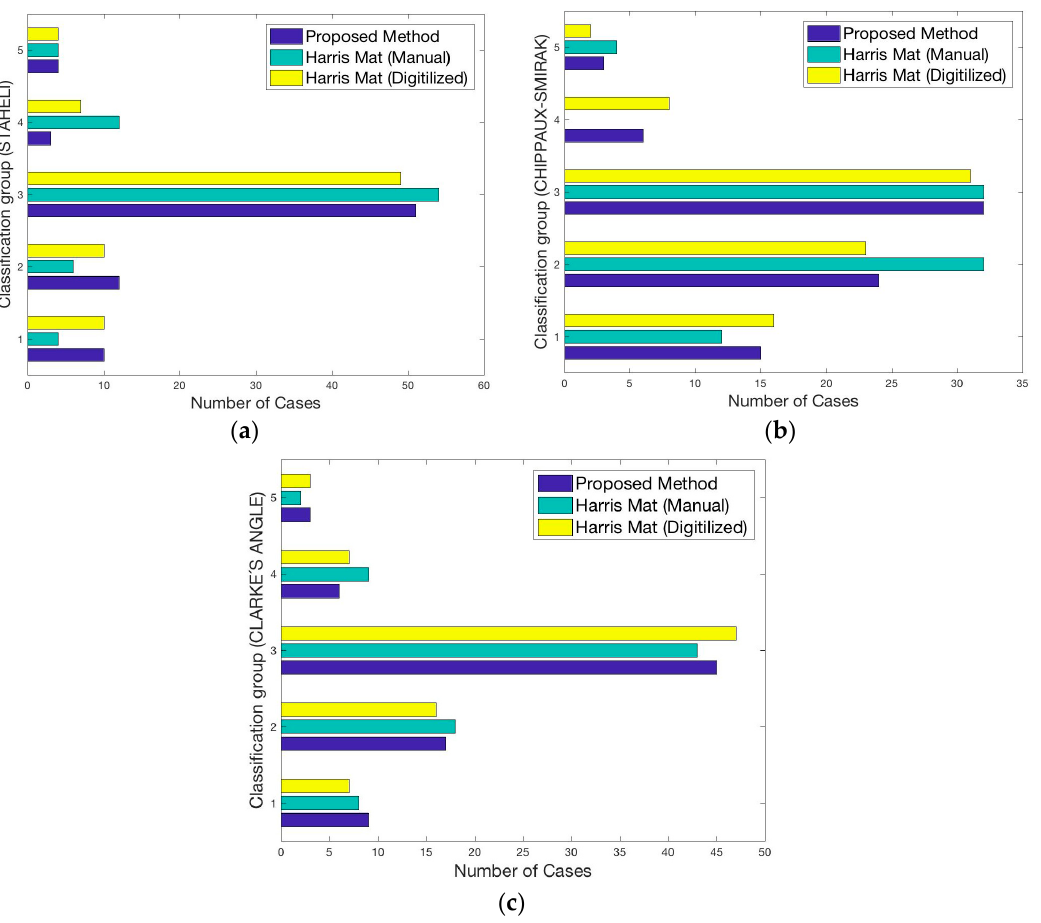
Figure 13. Accuracy analysis performed on three different datasets (proposed method, manual ink mat and digitalized ink mat). The vertical axis represents the five groups of classified footprints. The horizontal axis gives the number of cases in the respective group: ( a ) Staheli index; ( b ) Chippaux-Smirak Index; ( c ) Clarke’s Angle. Table 4. Comparison of values obtained from the evaluated methods and their respective correlation coefficient.